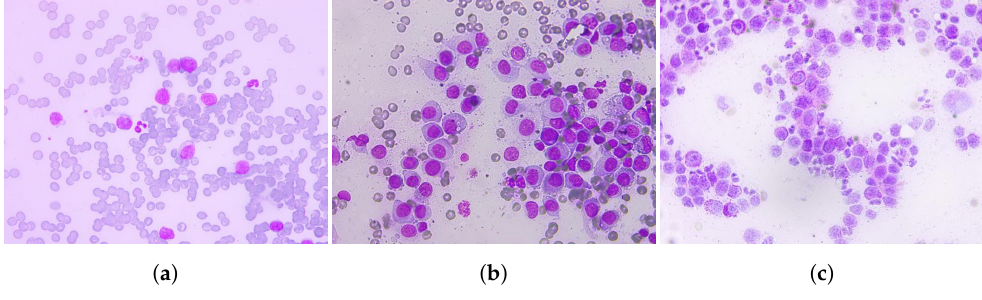
Figure 3. Example cancer cells. ( a ) Lymphoma. ( b ) Histiocytoma. ( c )